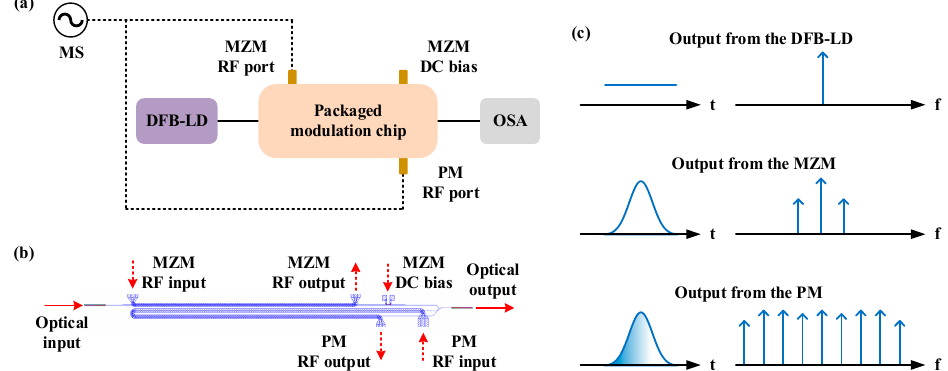
Figure 1. Schematic diagram of the OFC generation, based on a packaged monolithic integrated LNOI intensity and phase modulator. ( a ) Experimental setup of the OFC generation. ( b ) Layout of the monolithic integrated LNOI modulation chip. DFB-LD: distributed feedback laser diode; MZM: Mach–Zehnder modulator; PM: phase modulator; MS: microwave source; OSA: optical spectrum analyzer; DC: direct-current. ( c ) Temporal waveforms and spectra from DFB-LD, MZM and PM .